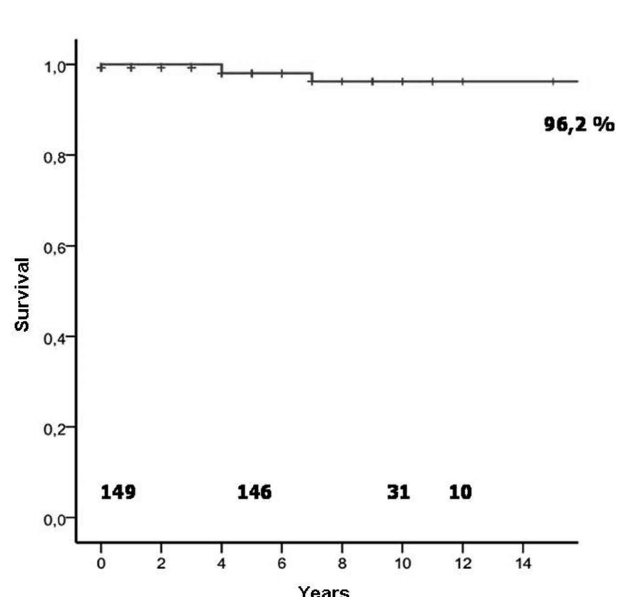
Fig. 5 - Actuarial survival curve in 149 patients followed in the long